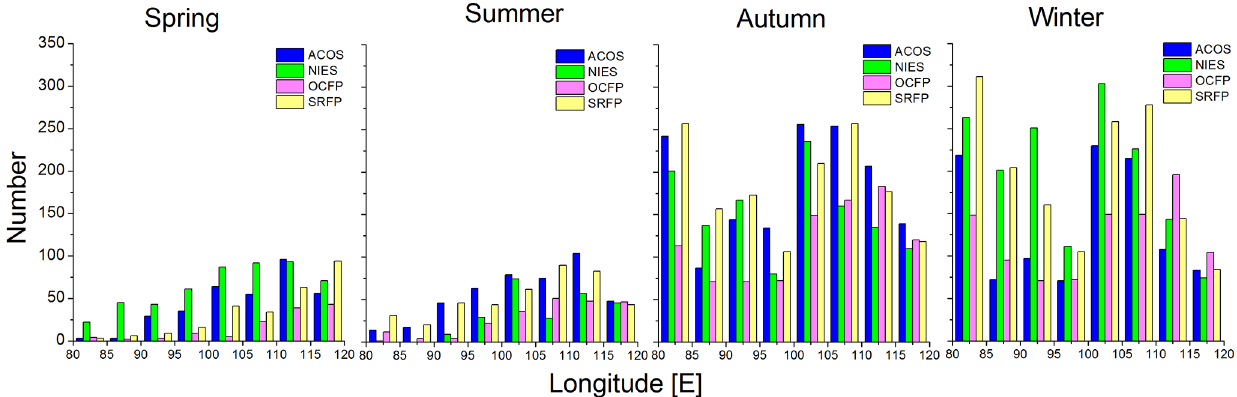
Figure 2. Number of single scans from the four GOSAT-XCO 2 data sets from ACOS, NIES, OCFP and SRFP over each of the 5 × 5 ◦ cells for different seasons (spring: MAM; summer: JJA; autumn: SON; winter: DJF) from March 2010 to February 2013.